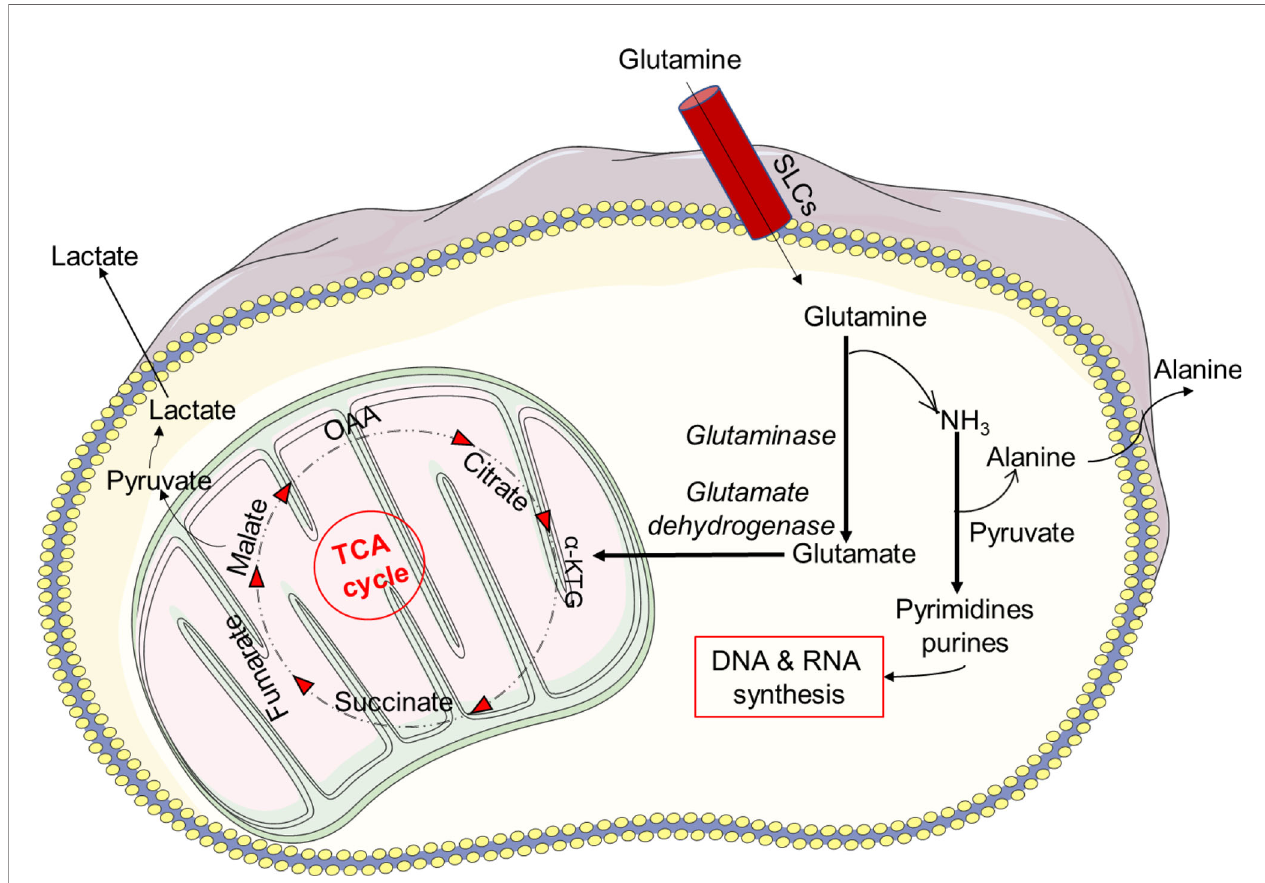
FIGURE 4 | Glutamine metabolism. Glutamine metabolism results in glutamate, aspartate, lactate and ammonia production. Under physiological conditions glutamine is required for the synthesis of nucleotide precursors, such as RNA and DNA. The sodium-coupled neutral amino acid transporter (SNAT) family of proteins is one of several carrier type transporters (SLCs) responsible for bringing glutamine into the cell. Once inside the cell, glutamine is oxidized and transformed into glutamate. Furthermore, glutamate enters the mitochondria and becomes oxidized and metabolized to a -ketoglutarate, which allows NAD + to be oxygenated and converted to NADH. The TCA cycle may accept a -ketoglutarate and create malate, which is subsequently transformed to pyruvate by the malate dehydrogenase, which oxygenates NADP +